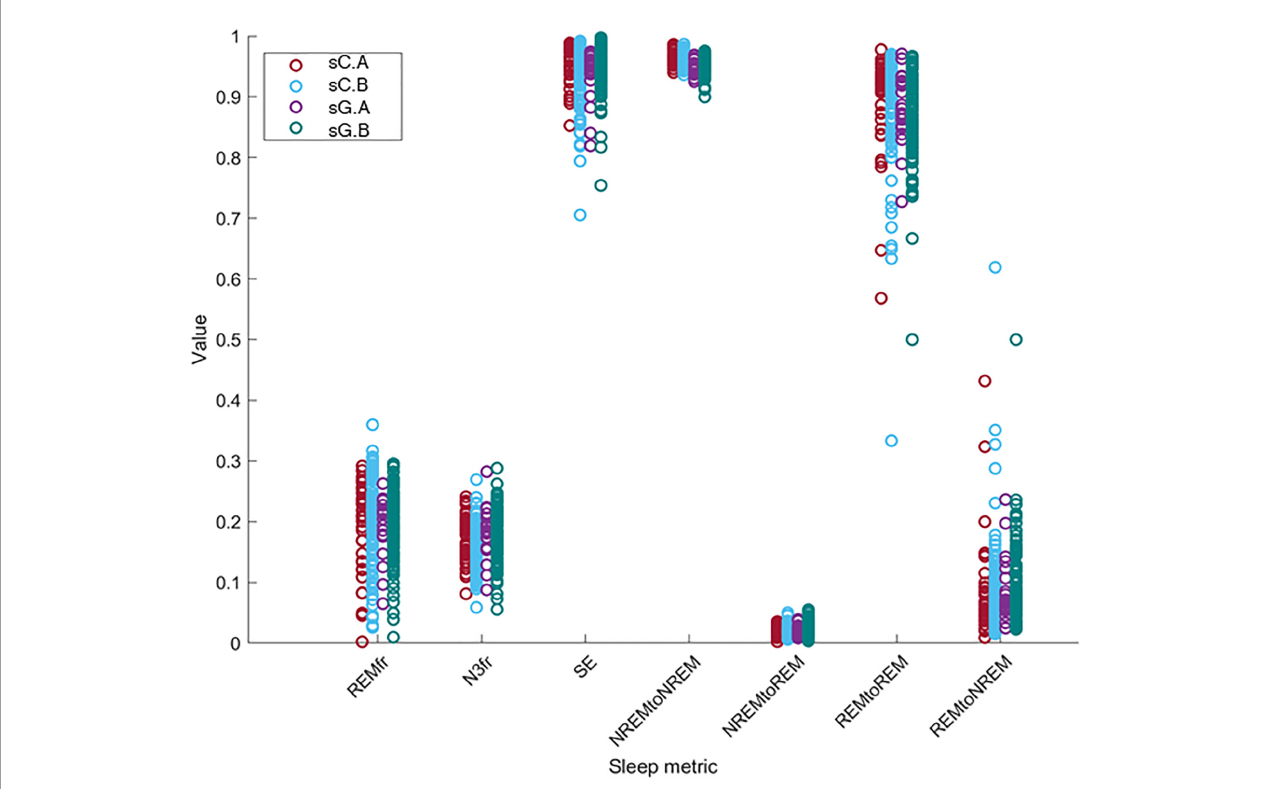
FIGURE8 The distribution of the value of the sleep metrics (REMfr, N3fr, SE, NREM to NREM, NREM to REM, REM to REM, and REM to NREM) for sC.A, sC.B, sG.A, and sG.B datasets show a large overlap and no clear equipment or part differences.